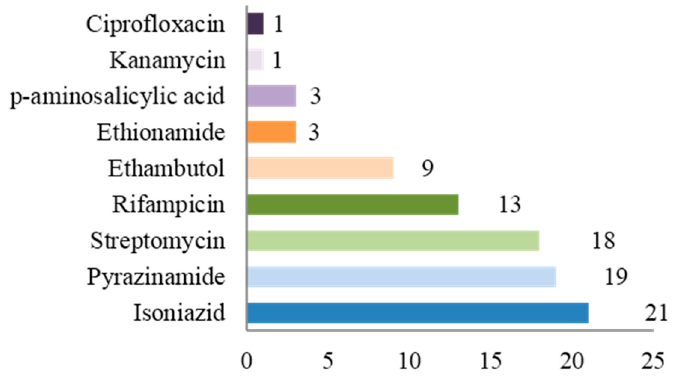
Figure 1. Resistances per single drug ( n